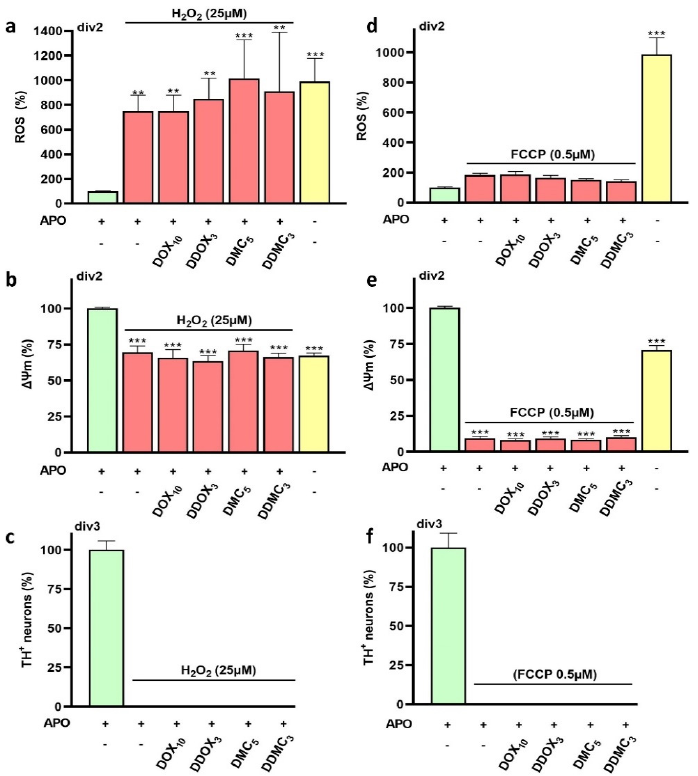
Figure 9. DOX , DDOX , DMC, and DDMC are ineffective against acute oxidative insults or mito- chondrial deficits induced in APO-treated cultures . ( a , b ) ROS and ΔΨ m monitored with DHR-123 and TMRM, respectively, in div2 midbrain cultures treated with APO (100 µg/mL) to prevent spon- taneous DA cell loss and challenged acutely with H 2 O 2 (25 µM) in the presence or absence of DOX (10 µM), DDOX (3 µM), DMC (5 µM), or DDMC (3 µM). As a comparison, we also estimated ROS levels in div2 sister cultures not treated with APO. Data expressed in % of APO-treated cultures are means ± SEM (5–10). ** p < 0.01, *** p < 0.001 vs. APO, only. One-way ANOVA followed by Dunnett’s test. ( c ) Survival of DA neurons in APO-treated midbrain cultures challenged acutely at div2 with H 2 O 2 in the presence or absence of the test TCs and then left to recover with the same treatments until div3 for survival assessment. Data expressed in % of APO-treated cultures are means ± SEM (n = 3). ( d , e ) ROS and ΔΨ m production monitored in div2 midbrain cultures treated with APO and challenged acutely with FCCP (0.5 µM) in the presence or absence of the same treatments as in ( a ). As a comparison, ROS levels and changes in ΔΨ m were estimated in div2 cultures not treated with APO. Data expressed in % of APO-treated cultures are means ± SEM (5–10). *** p < 0.001 vs. APO, only. One-way ANOVA followed by Dunnett’s test. ( f ) Survival of DA neurons in APO-treated mid- brain cultures challenged acutely at div2 with FCCP (0.5 µM) in the presence or absence of the test TCs and then left to recover with the same treatments until div3 for survival assessment. Data ex- pressed in % of APO-treated cultures are means ± SEM (n = 3). 3.8. The Protective Effects of TCs Are Still Observable When Low-Level Iron-Mediated Oxidative Stress Takes Place in Mature Midbrain Cultures We wanted to confirm that the effects of TCs for DA neurons remain observable in mature midbrain cultures. Precisely, we gradually replaced ACM from div7 midbrain cul- tures by DF12i supplemented with 2 µM MK-801. The cultures were then maintained in the presence or absence of various concentrations of DOX , DDOX , DMC , or DDMC until processing at div14. We used APO (100 µg/mL) as a reference protective treatment and